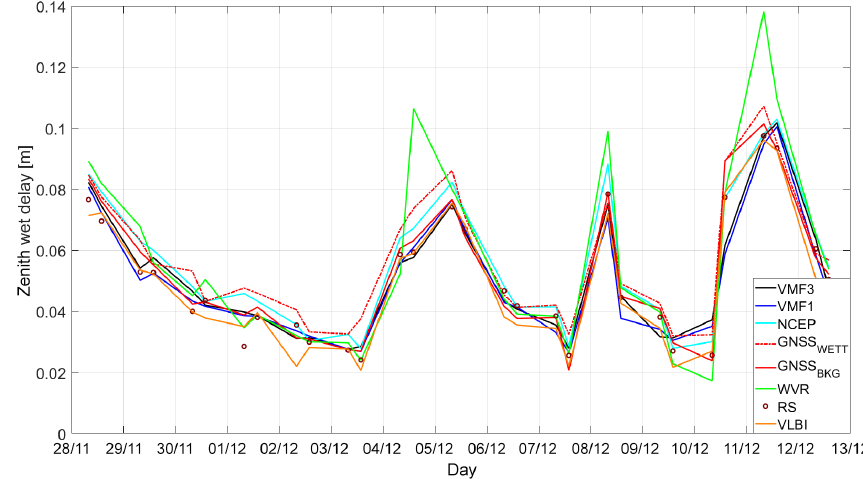
Figure 2. Comparison of zenith wet delays (cid:49)L z w at Wettzell.